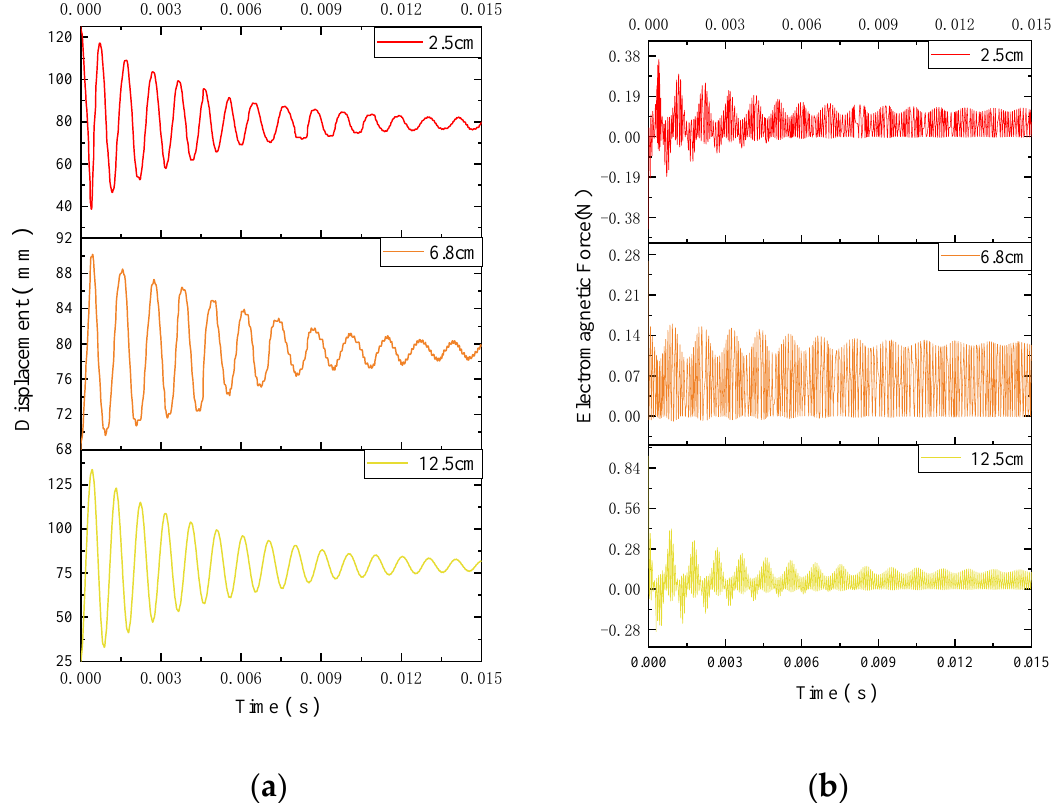
Figure3. Steady stateof foreign metalobjects at di ff erentinitial positions. ( a ) Longitudinal displacement; Figure 3. Steady state of foreign metal objects at different initial positions. ( a ) Longitudinal ( b ) longitudinal electromagnetic force displacement; ( b ) longitudinal electromagnetic force (EMF).